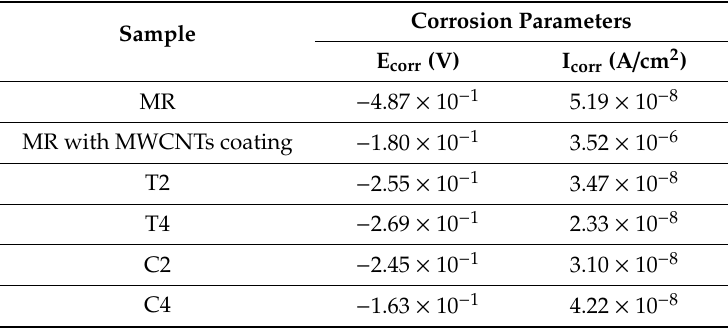
Table 5. Corrosion current density and corrosion potential of T2, T4, C2 and C4 laser-modified layers, non-laser-modified Ti13Zr13Nb substrate (MR) and MWCNTs